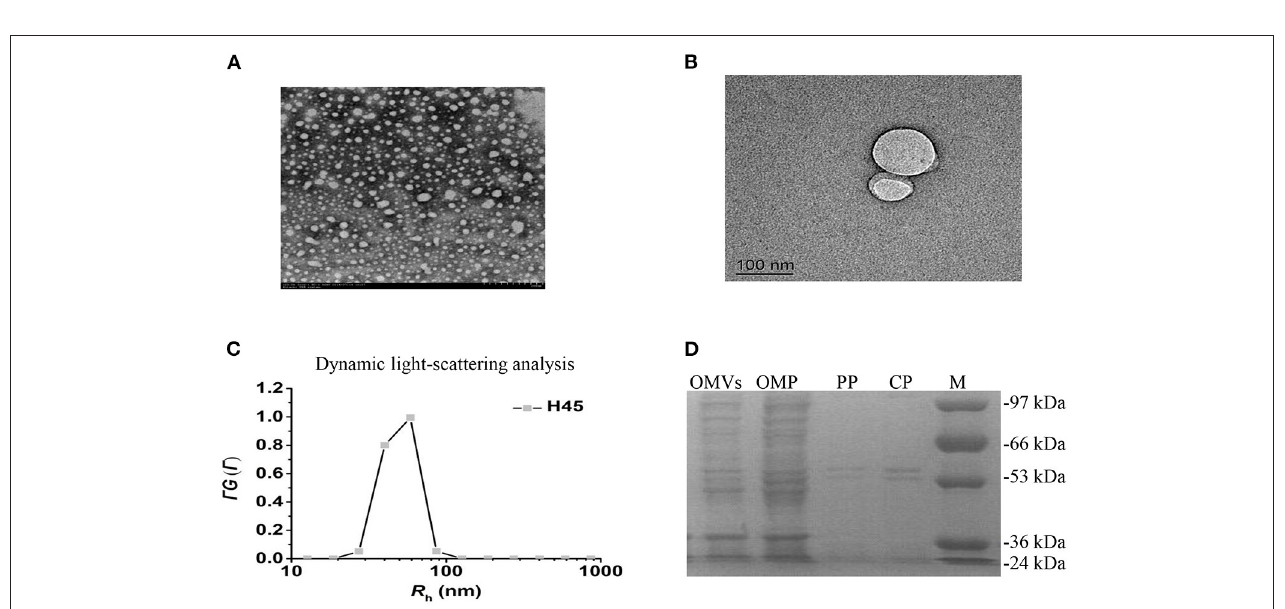
FIGURE 2 | Characteristics of OMVs isolated from H. parasuis H45 strain. (A) Negatively stained preparation of isolated H. parasuis OMVs showing size of OMVs. Scale bar: 200nm. (B) Transmission electron microscopy image of generation of one OMV from H45. Scale bar: 100nm. (C) CONTIN analysis of dynamic light scattering data. (D) Comparison of protein components in different parts of HPS by SDS-PAGE. OMV, Outer membrane vesicles; OMP, Outer membrane protein; PP, Periplasmic protein; CP, Cytoplasmic protein.